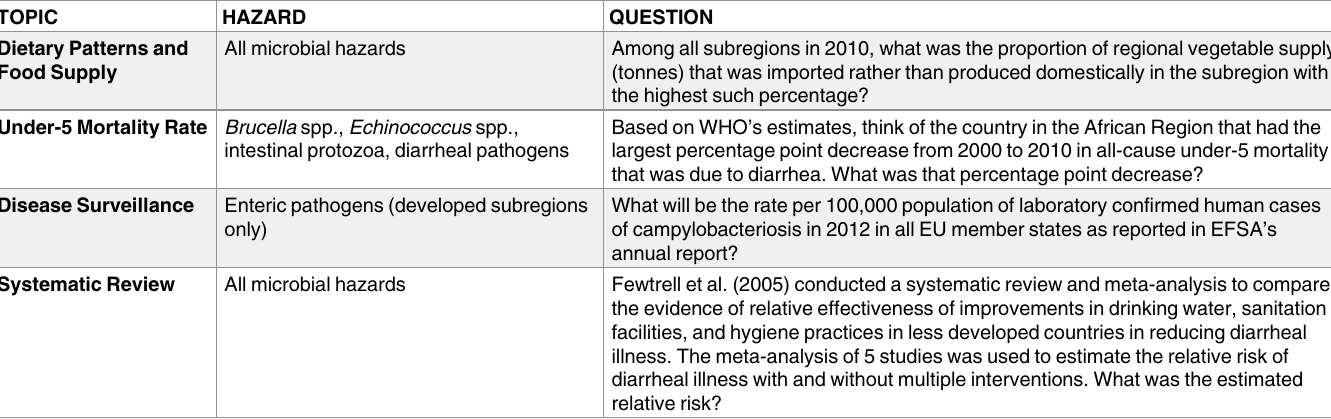
Table 2. Example calibration questions used in WHO global burden of foodborne disease source attribution expert